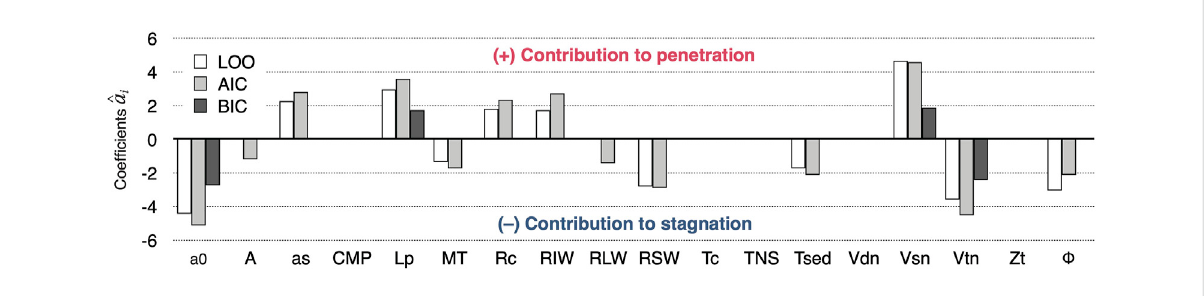
FIGURE 3 Selected variables and their coef fi cients ^ a i in the three optimal models that minimize LOO, AIC, and BIC. Positive and negative values indicate the contributions to penetration and stagnation of the subducted oceanic plates at the 660-km discontinuity, respectively.